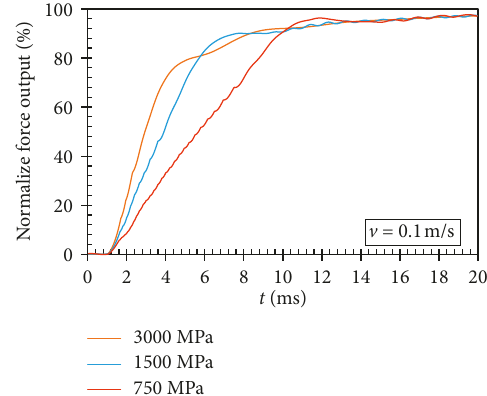
Figure 31: Influence of MR fluid bulk modulus on the force output at velocity 0.1m/s.